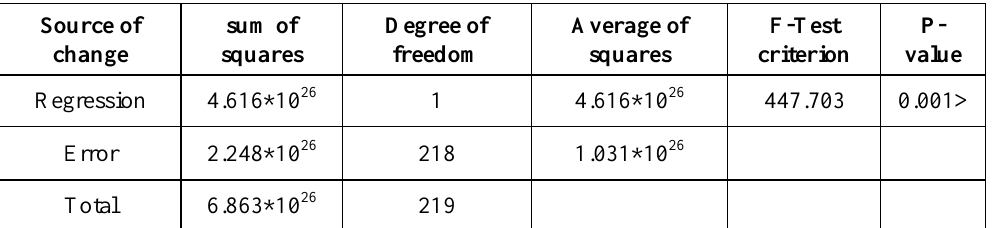
Table 4. Variance analysis of fitting 2017 cash flow regression line based on previous period cash flow